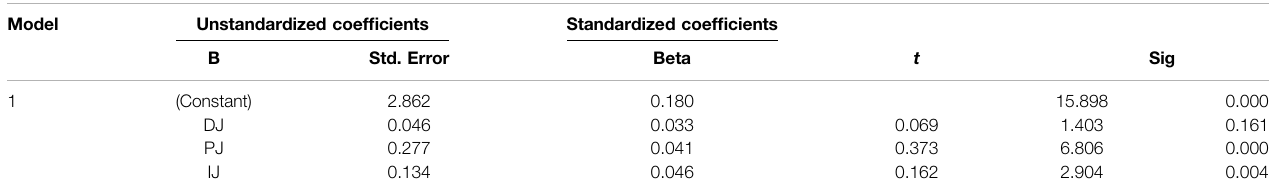
TABLE 8 | Case C: H2. Coef fi